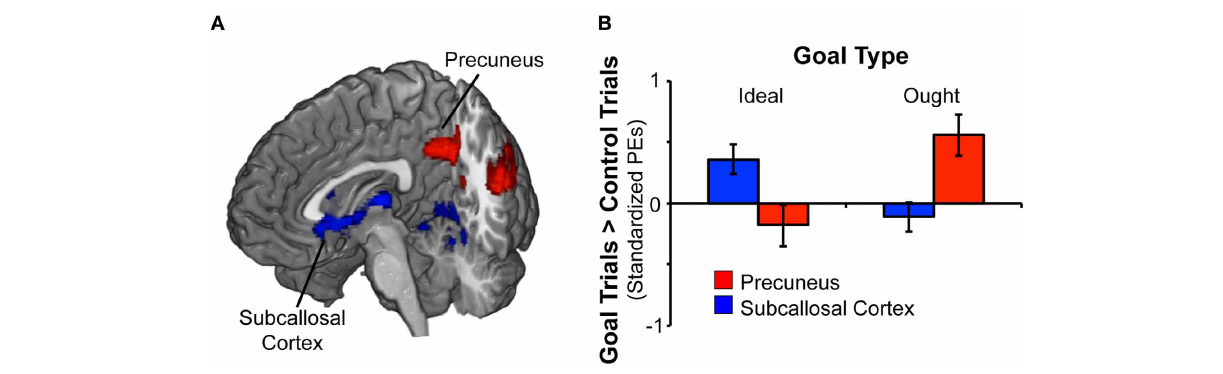
effect for prevention goal priming in precuneus and posterior cingulate gyrus (shown in red). (B) The chart displays mean standardized parameter estimates (PEs) at selected sites for the ideal vs. control contrast as well as the ought vs. control contrast. Within the subcallosal cortex ( x − 10, y 26, z − 10), activation was significant greater in response to ideal priming (vs. control priming). Within the precuneus ( x − 32, y 14, z 46), activation was significantly greater in response to ought priming (vs. control